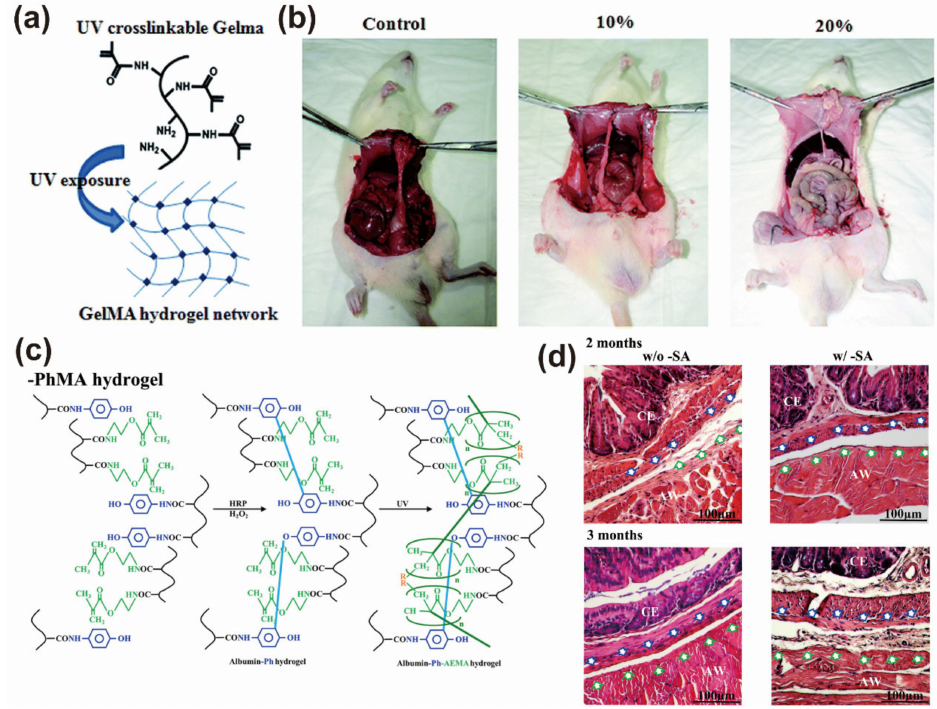
Figure 7. ( a ) Schematic illustration of GelMA hydrogel network. ( b ) The evaluation of a rat cecum abrasion model after 14 days. The results showed that 20% GelMA hydrogel film had the best anti-adhesion property. Reprinted with permission from Ref. [173]. Copyright 2011 RSC publication. ( c ) Schematic illustration of the synthesis of BSAPhMA albumin-based hydrogels. ( d ) H and E- stained sections of the abdominal and cecum sidewalls of mice treated with BSAPhMA hydrogels without salicylic acid and with salicylic acid at 2 and 3 months after treatment. The blue arrows and green arrows point to the repaired mesothelial layer of the abdominal cecum and wall, respectively. Reprinted with permission from Ref. [174]. Copyright 2021 American Chemical